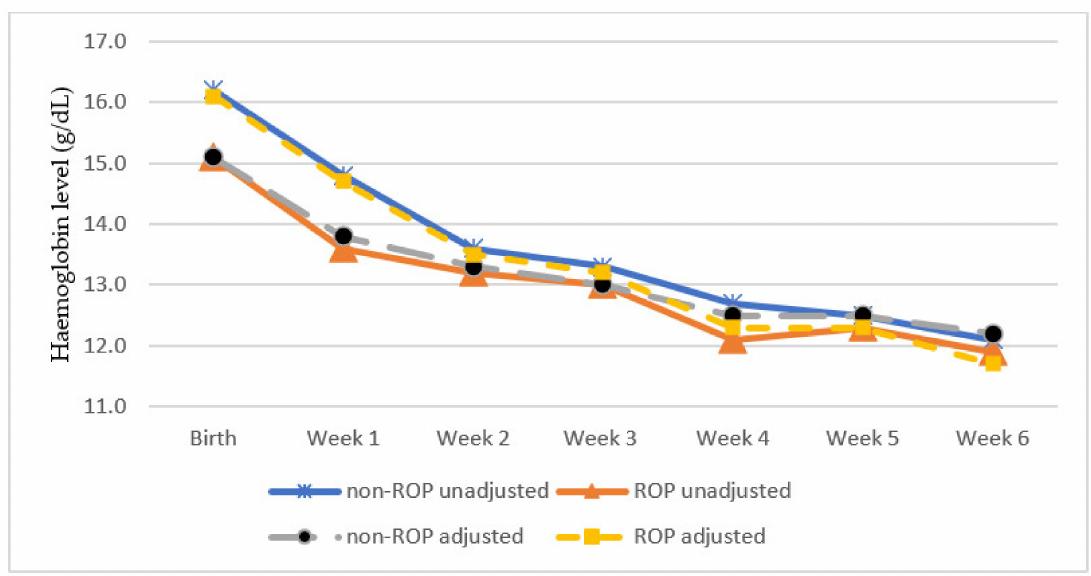
Figure 1. Mean haemoglobin levels in the first 6 weeks of